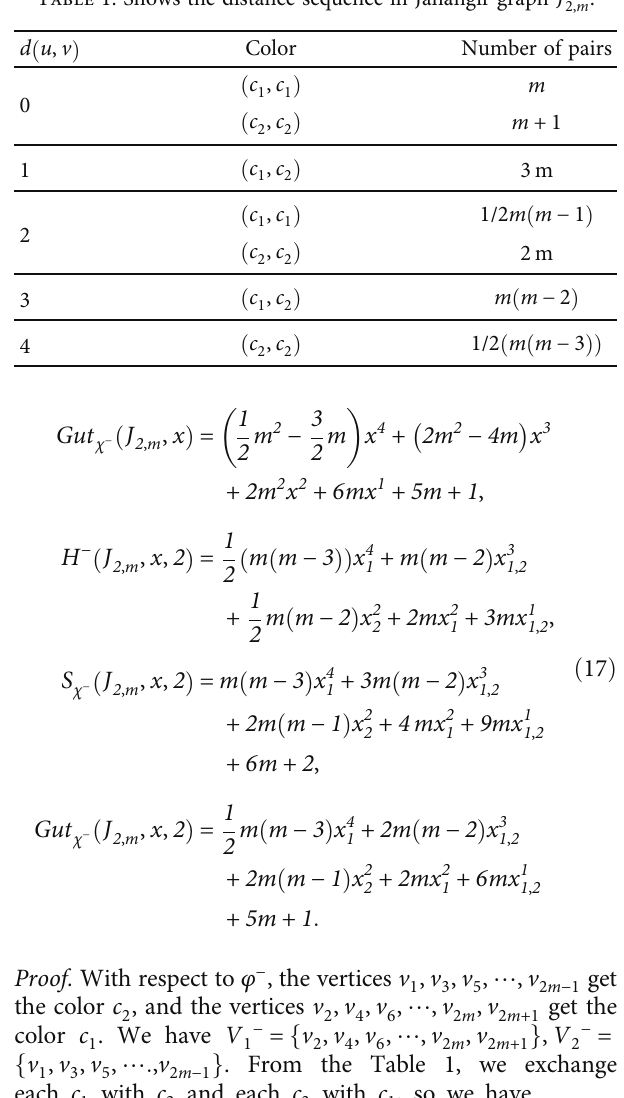
Table 1: Shows the distance sequence in Jahangir graph J